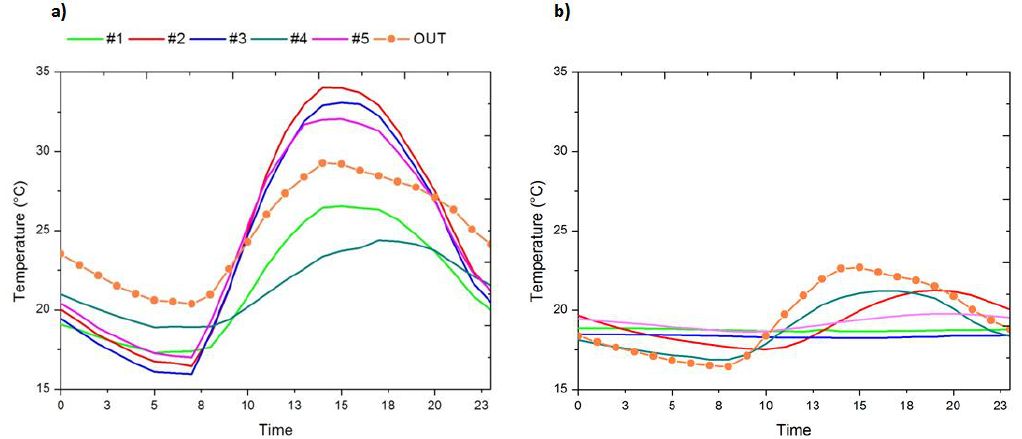
Figure 6. Mean daily trajectories of temperature, ( a ) for data recorded from 25 July 2013 to 12 August 2013; ( b ) for data recorded from 13 August 2013 to 8 October